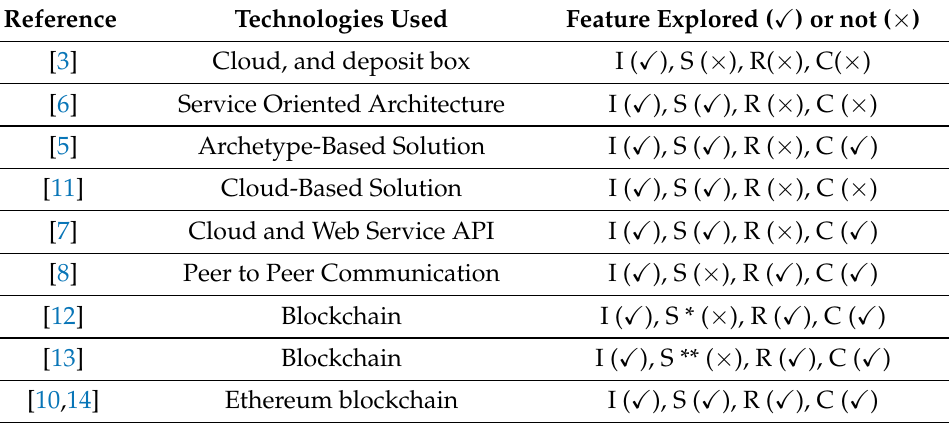
Table 1. Existing work. I means interoperability, S means security, R means response time, C means compatibility, * means database and ** means authentication, (cid:88) means the feature is explored and × means the feature is not